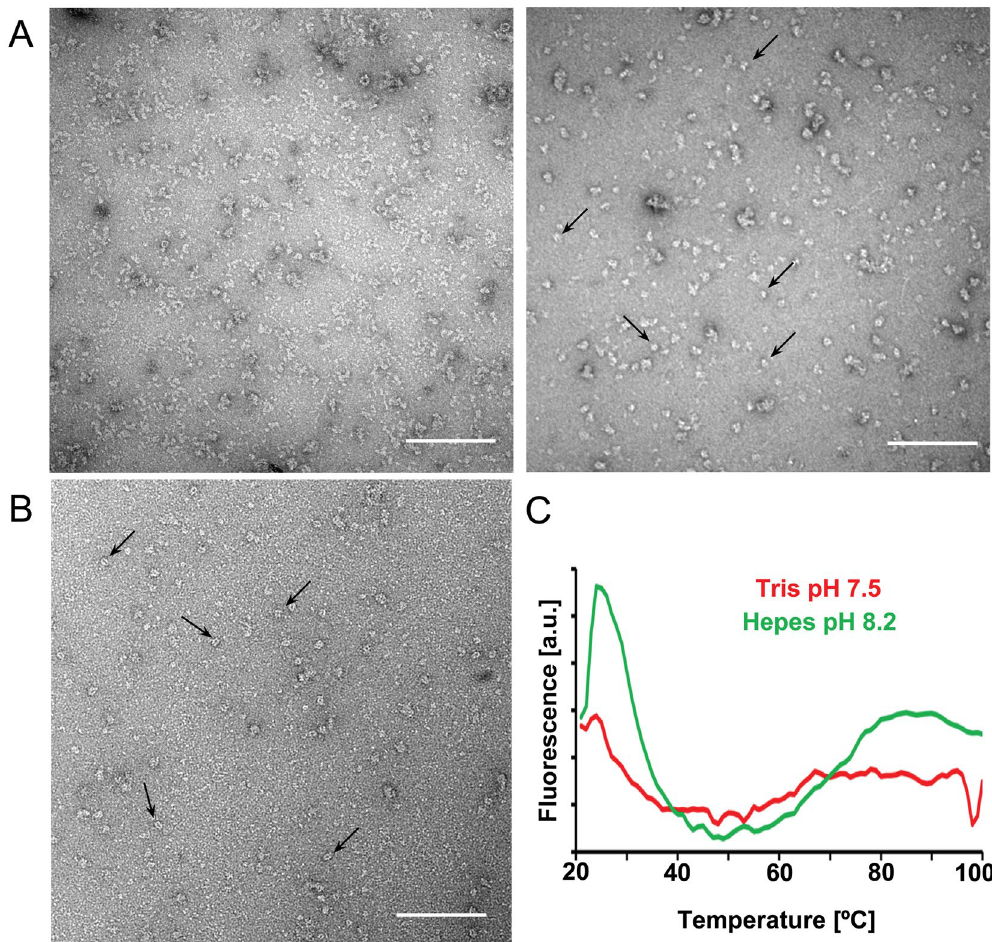
Figure 4. Negative stain TEM of 3xflag-LRRK2 and 3xflag-LRRK1 and buffer optimization for 3xflag-LRRK2 by ProteoPlex screening. ( A ) (Left) Negative stain TEM micrograph of LRRK2 purified in binding buffer at pH 7.5 and eluted in elution buffer Tris/HCl at pH 7.4 after a wash step. The sample is heterogeneous with many disintegrated protein particles in the background and some aggregates. (Right) Negative stain TEM micrograph of the LRRK2 sample purified in binding buffer at pH 6.8 and eluted in elution buffer at pH 8.2 as suggested by ProteoPlex screening. Although there is still some heterogeneity, more particles are intact (arrows) and the background is much cleaner. Scale bars: 100 nm. ( B ) Negative stain TEM micrograph of LRRK1 purified as described in Materials and Methods with Tris/HCl based binding buffer at pH 7.5 and eluted in Tris/HCl based elution buffer at pH 7.4. Distinct dimeric LRRK1 particles can be clearly seen (arrows) with few aggregates and smaller particles in the background. Scale bars: 100 nm. ( C ) ProteoPlex melting curve profiles obtained for LRRK2 eluted in Tris pH7.4 and Hepes pH8.2. Relative fluorescent intensity is plotted for the temperature range of 20°–100 °C. The standard ProteoPlex algorithm could not be used to calculate a thermodynamic model, as the fluorescence signal was too low. Trend lines were calculated using a moving average with a period of 2. The melting curve displays already aggregation at 20 °C when a Tris pH 7.4 buffer was used to elute LRRK2, whereas a peak occurs at 25 °C and the curves displays a 2-state unfolding between 20 and 40 °C when the elution was performed with Hepes 8.2, indicating that this buffer places the LRRK2 protein in more favorable conditions, i . e ., predictive of stable and monodisperse protein complexes. This latter buffer was then used as the basis for LRRK2 elution in subsequent preparations of LRRK2 protein for cryo-EM. Additional melting curve profiles for the buffer screens (binding buffer and elution buffer screens) are given in Supplementary Figures S1, S2 and